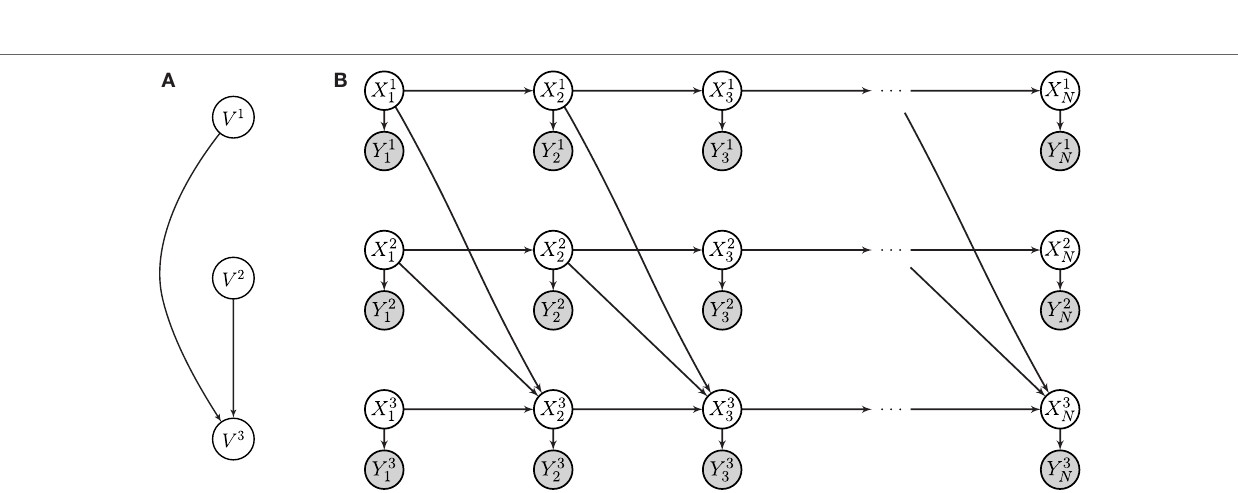
Frontiers in Robotics and AI |